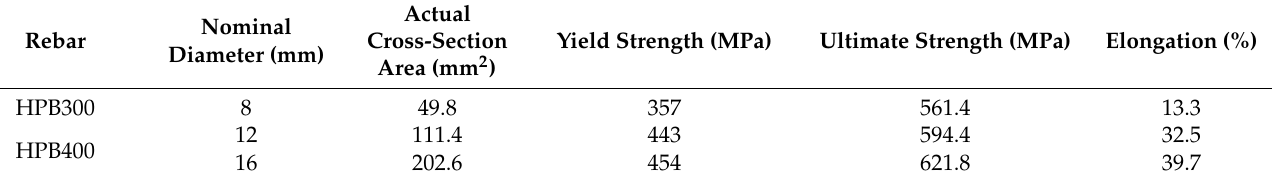
Table 4. The properties of reinforcing bar.